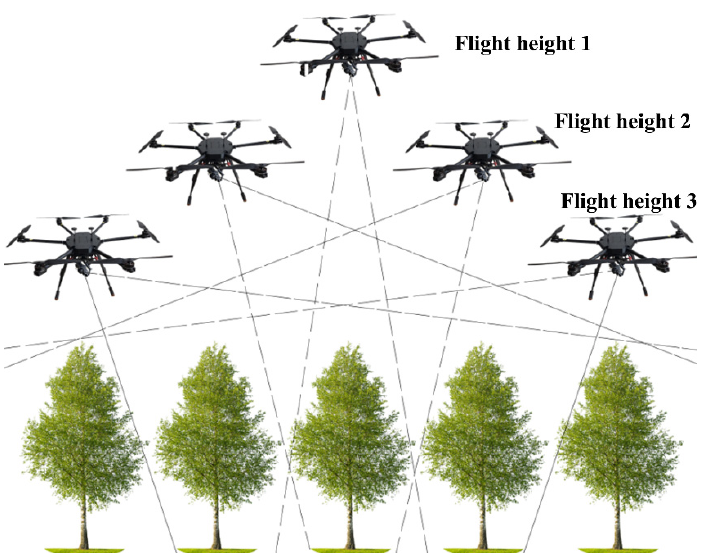
Figure 3. Insight for acquiring UAV optical images of different angles to construct 3D